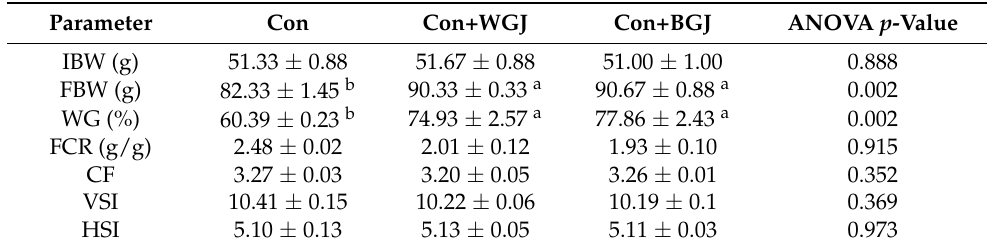
wheat grass juice and barley grass